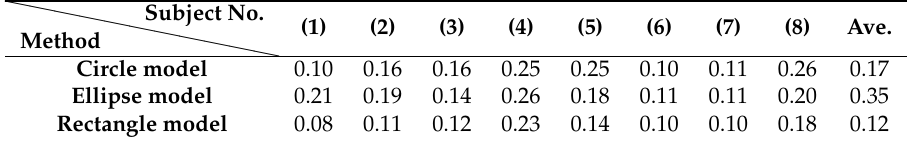
Table 1. RMS of the AP-diameter estimation error. (cid:96)